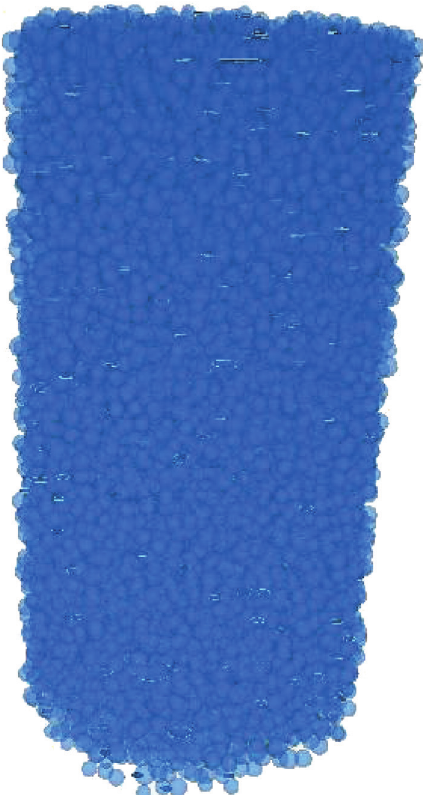
Figure 8: Reconstructed PFC3D model of coal sample.